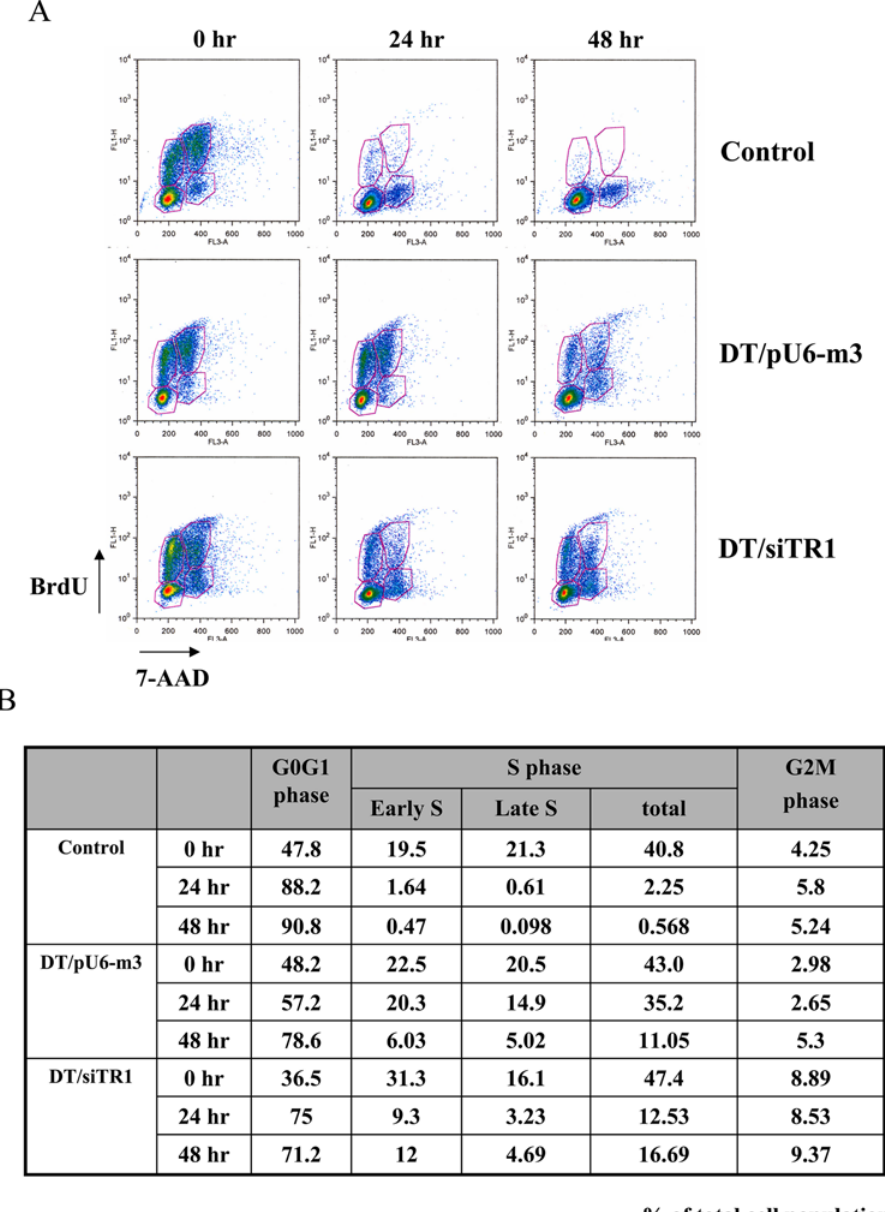
Figure 3. Cell cycle analysis. Control, DT/pU6-m3 and DT/siTR1 cells were grown in serum-deficient medium for 0, 24 and 48 hrs and incubated with BrdU for 6 hours. Harvested cells were stained with anti-BrdU antibody to monitor newly replicated genomic DNA and 7-AAD to monitor whole genomic DNA. ( A ) Stained cells were analyzed by flow cytometry and ( B ) quantitated in each phase of the growth cycle by FlowJO. Phases of the growth cycle, G0-G1, S phase (Early S and Late S) and G2-M were shown and the values given represent the percent of the total cell population. Details of the experiments shown in the figure are given in Methods.